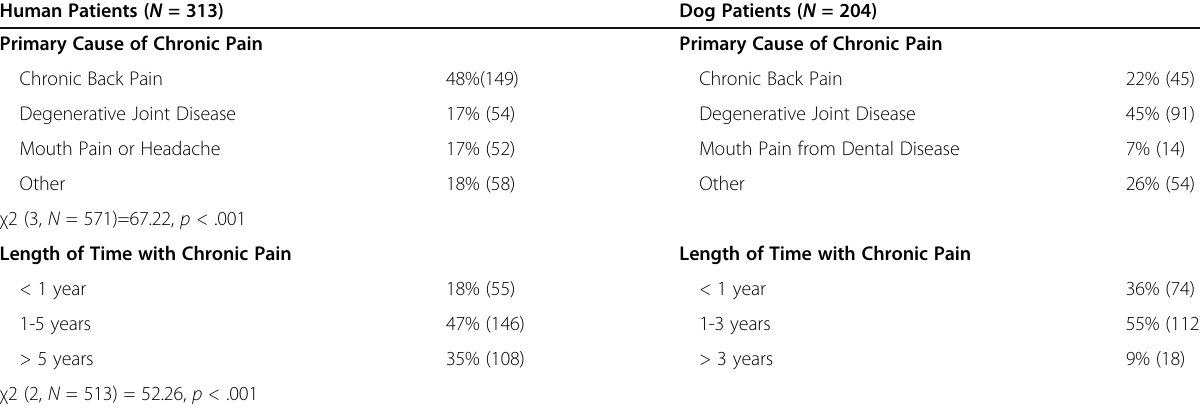
Table 1 Comparisons by Causes and Length of Time with Chronic Pain for Human Patients versus Dog Patients Human Patients ( N = 313) Dog Patients ( N = 204) Primary Cause of Chronic Pain Primary Cause of Chronic Pain Chronic Back Pain 48%(149) Degenerative Joint